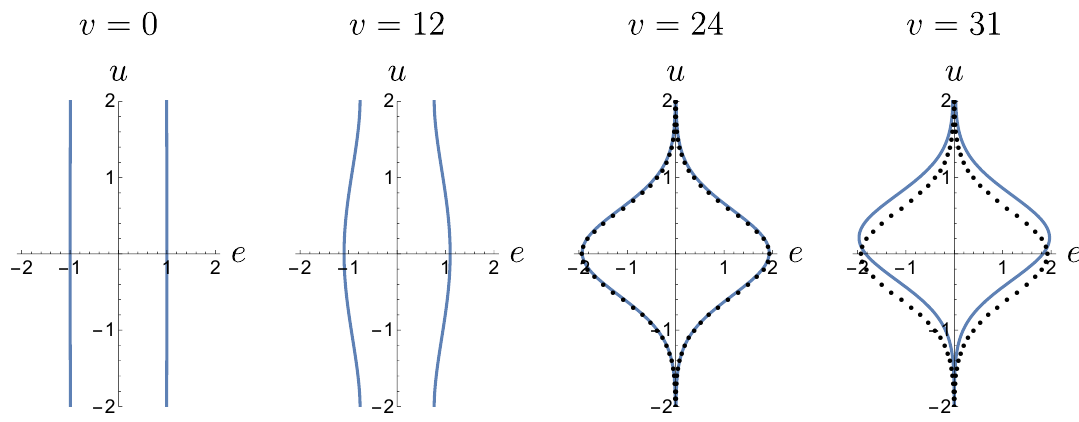
Figure 6 . Response of the uniform black hole to the perturbation (cid:14)e = (cid:15)u 2 with (cid:15) < 0 for the rescaled equations (3.9). The reference radius of the black hole is r c = 0 : 4. For the last two plots, we overlap the steady gaussian solution (3.15) as dotted lines. The amplitude e 0 (cid:24) 1 : 94 was (cid:12)tted to the solution at v = 24. This gaussian state moves until NDSolve crashes shortly after v =